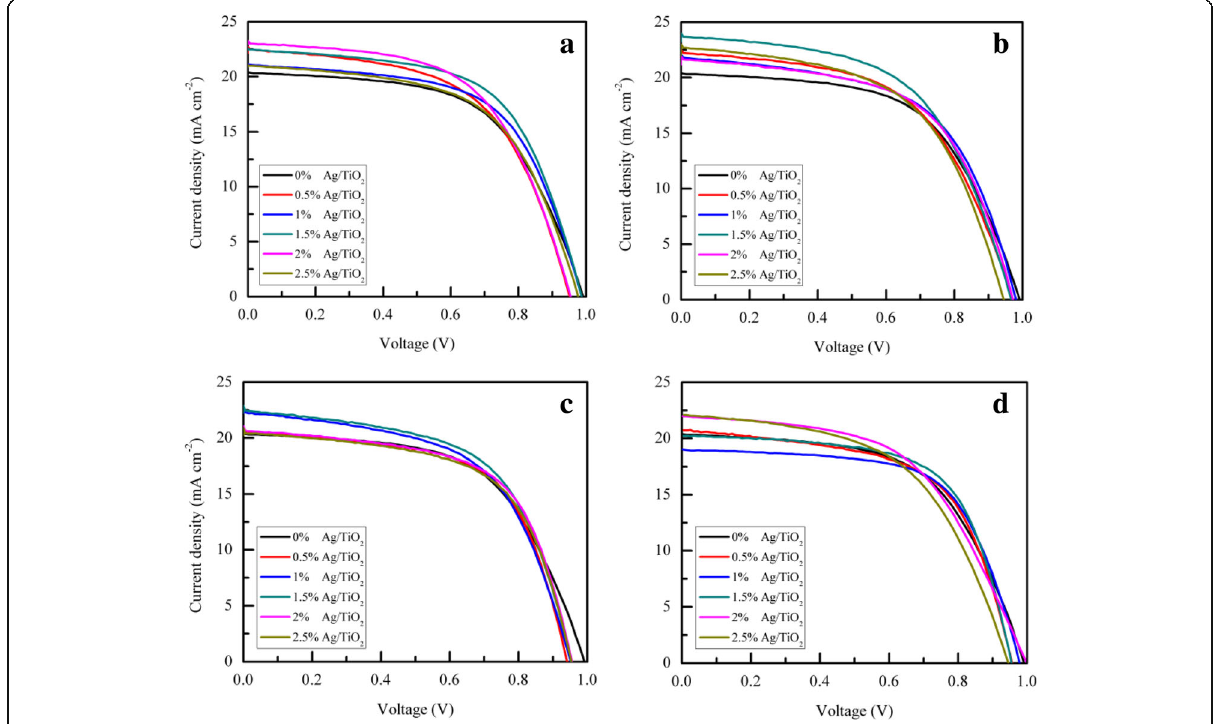
Fig. 6 J - V curves of PSC devices with different content of various size of Ag NPs of a 10 nm, b 30 nm, c 40 nm, and d 55